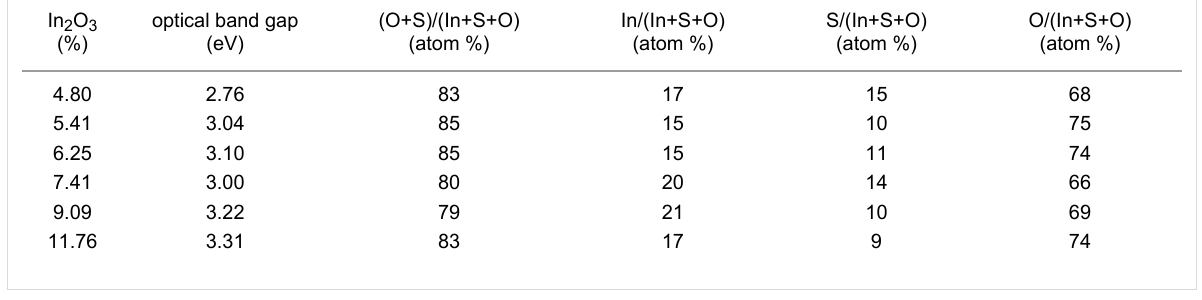
Table 2: EDX measurements data from In 2 (S,O) 3 thin films when using O 2 plasma. In 2 O 3 (%)